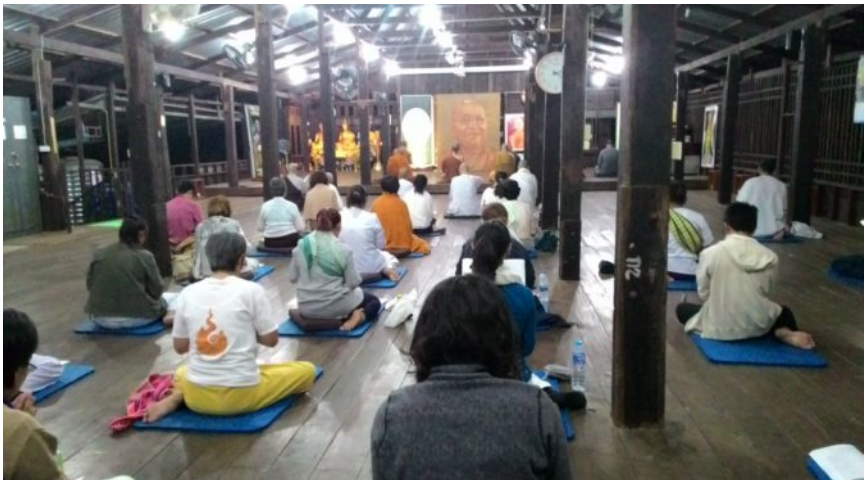
Figure 3. Some Chinese nuns and laywomen visited and stayed at Wat Pa Sukato at Khonkean in Thailand (Photo taken by the